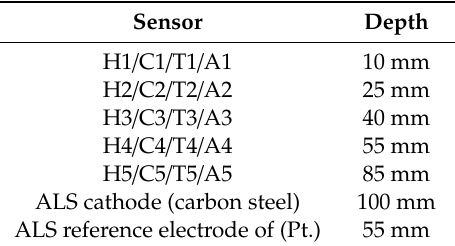
Figure 2. Position of Ag / AgCl electrode, MnO 2 electrode, anode Ladder monitoring system (ALS), temperature sensor and humidity sensor in mortar sample. Table 1. Embedded depth of sensors.